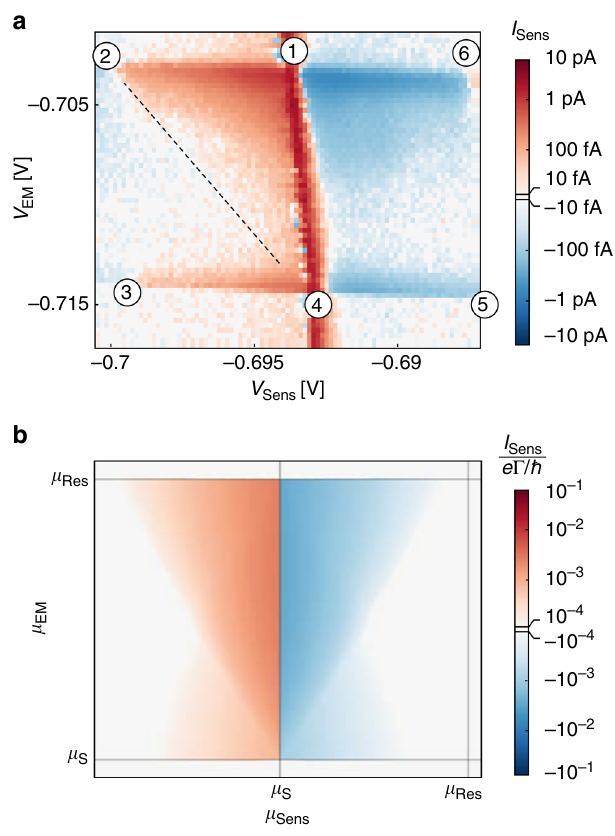
Fig. 4 Direct spectroscopy of Auger-like processes. a 2D-colour plot of the current through the Sensor QD for varying Sensor QD ( x -axis) and Emitter QD plunger gate voltage ( y -axis). The signal is plotted on a logarithmic scale preserving the direction of electron tunnelling in the colour code. The dashed line corresponds to the maximal energy which can be transferred by (cid:1) μ ¼ μ (cid:1) μ Auger-like recombination: μ max . b Calculated current Sens S S EM through the Sensor QD for the experimental situation depicted in ( a ). Γ is the tunnelling rate through the